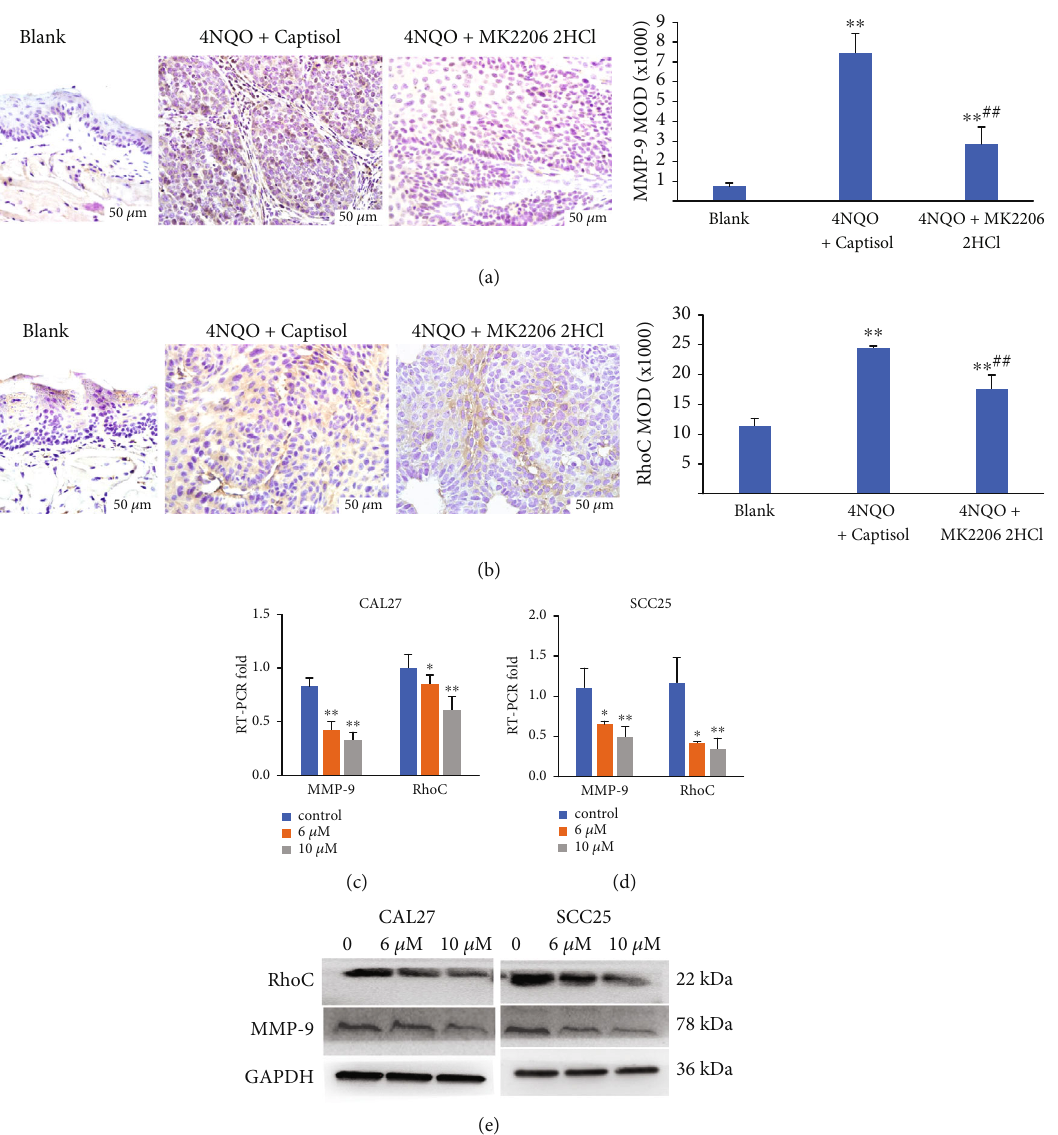
Figure 12: Inhibitory e ff ects of AKT inhibitor on MMP-9/RhoC expression. (a) MK2206 2HCl inhibited MMP-9 expression in 4NQO- induced tongue tumors. (b) MK2206 2HCl inhibited RhoC expression in 4NQO-induced tongue tumors. All data are presented as the mean ± SD : ∗∗ P < 0 : 01 as compared with the blank group, ## P < 0 : 01 as compared with the 4NQO+captisol group. Magni fi cation × 400. (c) MK2206 2HCl inhibited the RNA expression of MMP-9 and RhoC in CAL27 cells. (d) MK2206 2HCl inhibited the RNA expression of MMP-9 and RhoC in SCC25 cells. All data are presented as the mean ± SD : ∗∗ P < 0 : 01, ∗ P < 0 : 05 as compared with the control group. (e) MK2206 2HCl inhibited the protein expression of MMP-9 and RhoC in OSCC